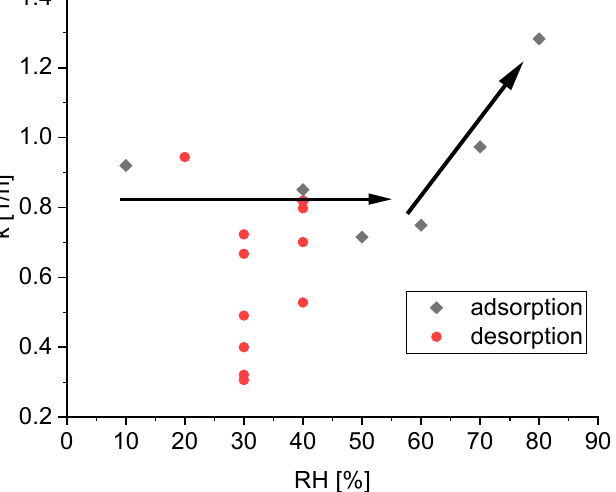
Figure 5. Calculated reaction rate constants k during the adsorption (black points) and desorption (red points) process of water on silica gel; the black arrows are added to visualize the tendency of the reaction rate constant of the adsorption.